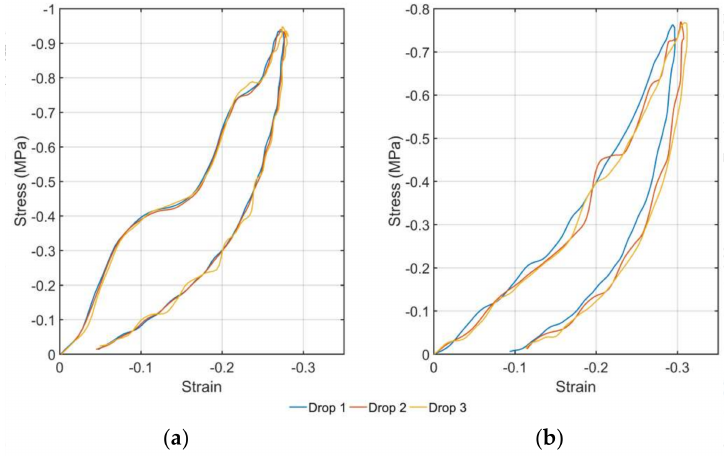
Figure 4. Stress-strain curves from 3 drops at the 55 mm drop height for the ( a ) Berleburger shockpad and ( b ) Holywell shockpad.